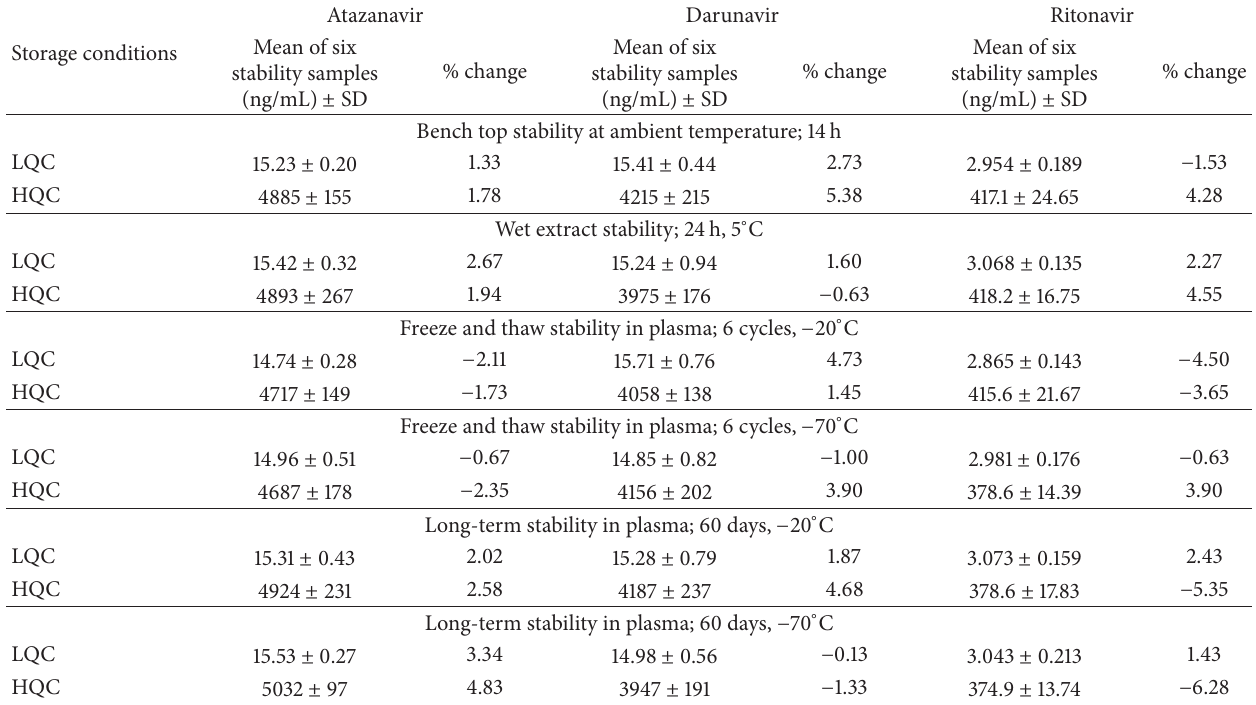
Table 6: Stability of atazanavir, darunavir, and ritonavir in human plasma under different